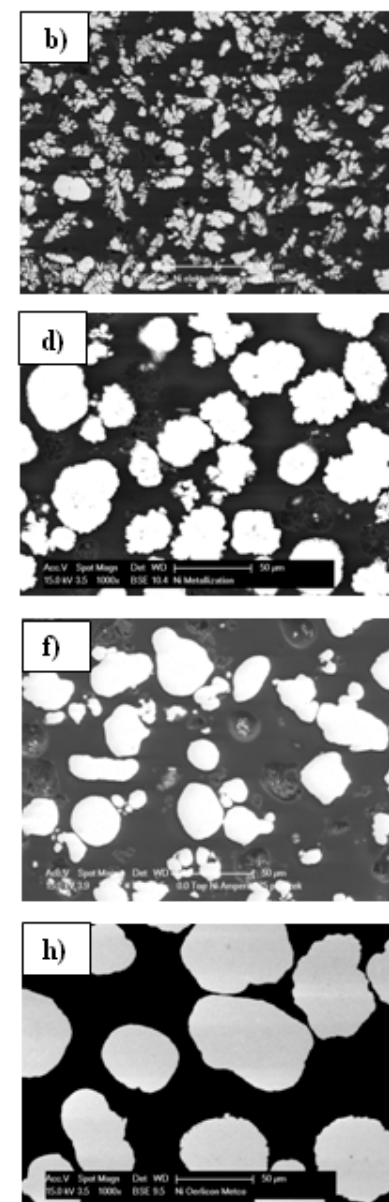
Figure 2. Morphology and cross-section of nickel powder grains: ( a , b ) C30 ; ( c , d ) M28 ; ( e , f ) A34 ; ( g , h ) O60 , respectively.